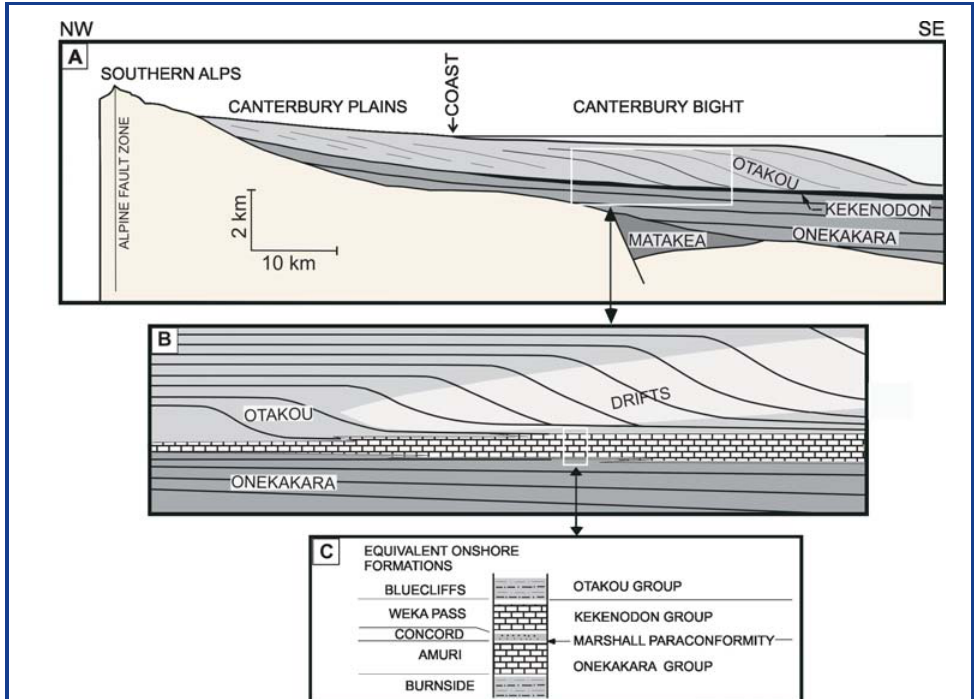
Figure 3. Schematic stratigraphy of the Canterbury Basin at three different scales. [A] Large-scale, post-rift stratigraphy (see profile location in Fig. 1). Onekakara, Kekenodon, and Otakou groups were deposited during regional transgressive, highstand, and regressive phases, respectively. [B] Seismic-scale stratigraphy. Sediment drifts occur within the Otakou Group. [C] Outcrop-scale stratigraphy across the Marshall Paraconformity. Modified from Fulthorpe et al.